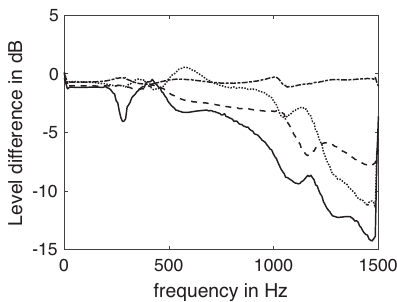
Figure 12. Level difference between prescribed pressure signals and pressure signal which is obtained for the reconstructed source signal assumed at erroneous position. The calculations are carried out for 1 ( — ), 2 ( ... ), 4 ( – ), and 8 (-.-)receiving positions.